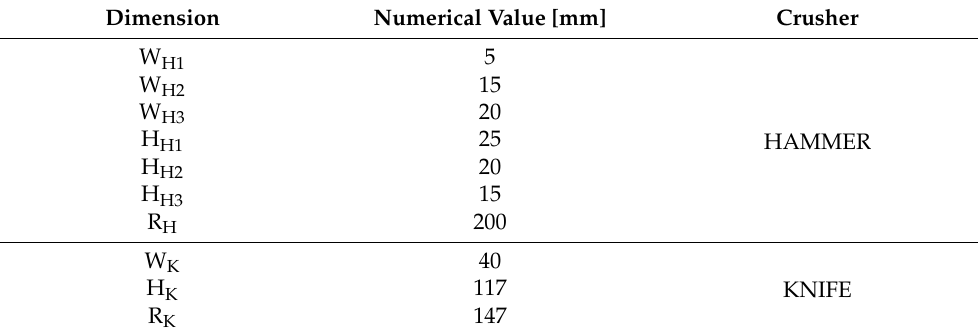
Table 1. Numerical value of crusher tool parameters. Dimension